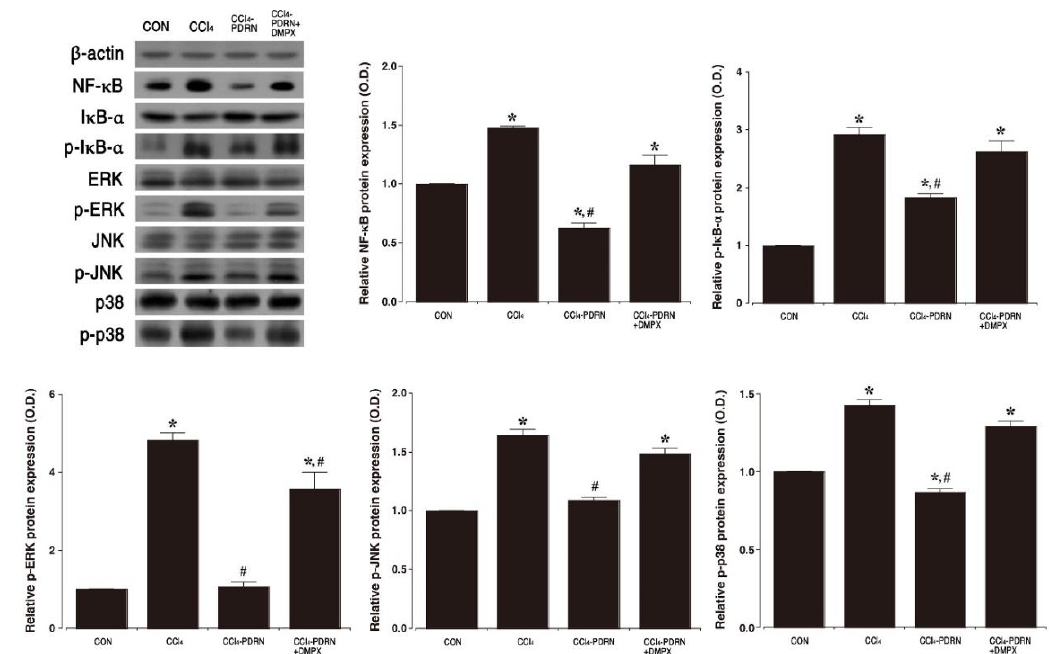
Figure 4. Expression of nuclear factor (NF)- κ B and cascade factors of mitogen-activated protein kinase (MAPK). Upper left panel: Representative expression of NF- κ B, NF- κ B inhibitor (I κ B)- α , extracellular signal-regulated kinase (ERK), c-Jun N-terminal kinase (JNK), p-38. Upper right panel: Relative expression of NF- κ B and relative ratio of phosphorylated I κ B- α (p-I κ B- α ) to I κ B- α . Lower panel: Relative ratio of phosphorylated ERK (p-ERK) to ERK, phosphorylated JNK (p-JNK) to JNK and phosphorylated p-38 (p-p-38) to p-38. CON, control group; CCl 4 , CCl 4 -injection group; CCl 4 -PDRN, CCl 4 -injection and polydeoxyribonucleotide (PDRN)-treated group; CCl 4 -PDRN + DMPX, CCl 4 -injection and PDRN with 3,7-dimethyl-1-propargylxanthine (DMPX)-treated group. * indicates p < 0.05 when compared with the control group. # indicates p < 0.05 when compared with the CCl 4 - injection group.